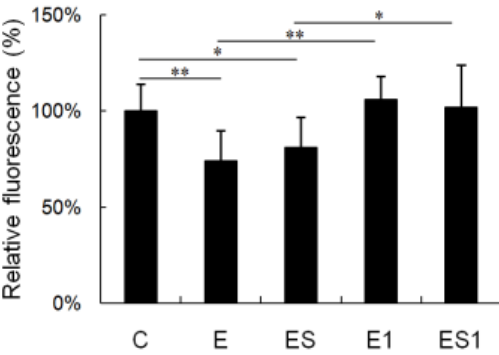
Figure 5. Effects of strenuous exercise and BCAA supplementation on the reactive oxygen species (ROS) generation of MФs. MФs were incubated with 2′, 7′ -dichlorofluorescein diacetate (DCFH-DA). DCFH-DA oxidation was monitored by flow cytometry. Data are means ± SD of relative fluorescence intensity. * p < 0.05; ** p < 0.01.